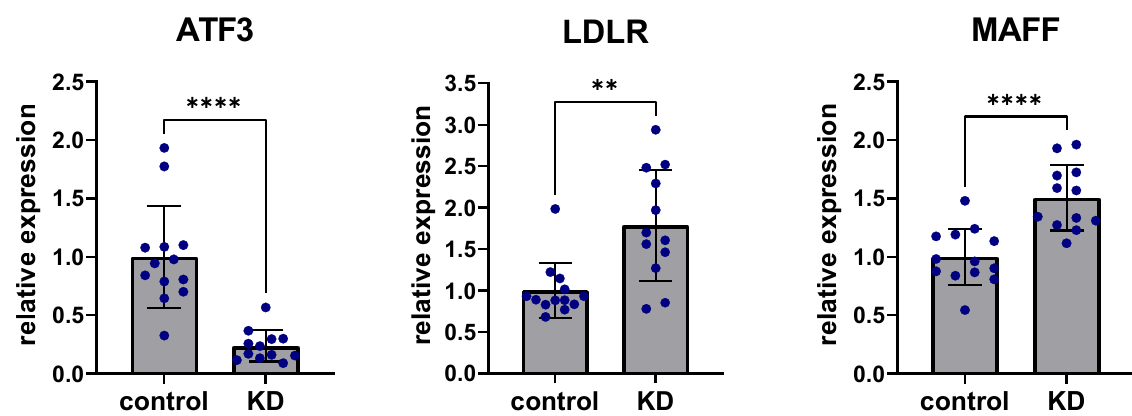
Figure 4. Knockdown of ATF3 perturbs expression of LDLR and MAFF. siRNA knockdown (KD) of ATF3 led to significant downregulation of ATF3 expression levels in human Hep3B liver cells after 48 h. siRNA knockdown of ATF3 significantly upregulated the predicted downstream targets LDLR and MAFF. ** p < 0.01, **** p < 0.0001. ATF3: Activating transcription factor 3F; KD: Knockdown of ATF3; LDLR: low-density lipoprotein receptor; MAFF: MAF basic leucine zipper transcription factor F.